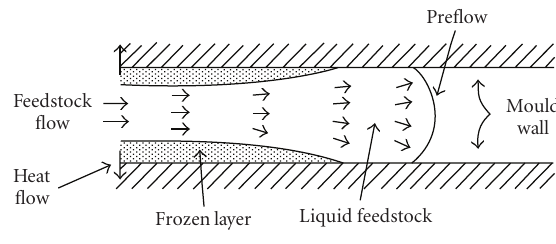
Figure 2: Molten feedstock flow along the mould canal.